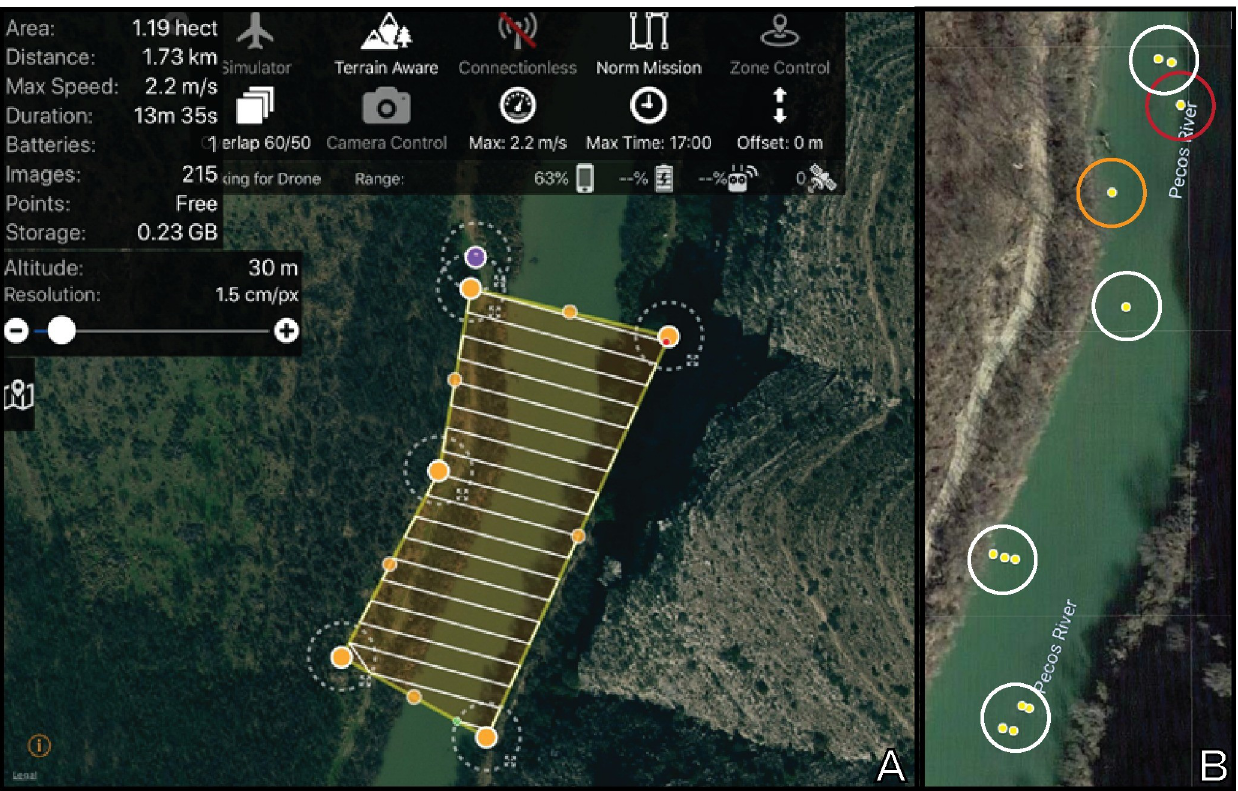
Fig 3. Programs used to conduct drone flights and process drone imagery. (A) Screenshot from the Maps Made Easy app that was used to conduct the majority of the drone flights during this project. The projected flight path and flight parameters are depicted for a flight on 10 August 2019 along the Pecos River, 0.8 river km upstream of confluence with Independence Creek, Crockett County. (B) Map showing locations of turtle detections during a drone survey for this same flight. By examining GPS locations of photographs containing turtles, the relative location of the detections could be determined to assist in turtle quantification. Turtles were captured in 12 photographs taken during this drone survey (yellow dots). However, multiple images often captured the same individual turtle, indicated by a circle (orange = Pseudemys gorzugi ; red = Trachemys scripta elegans ; white = Apalone spinifera